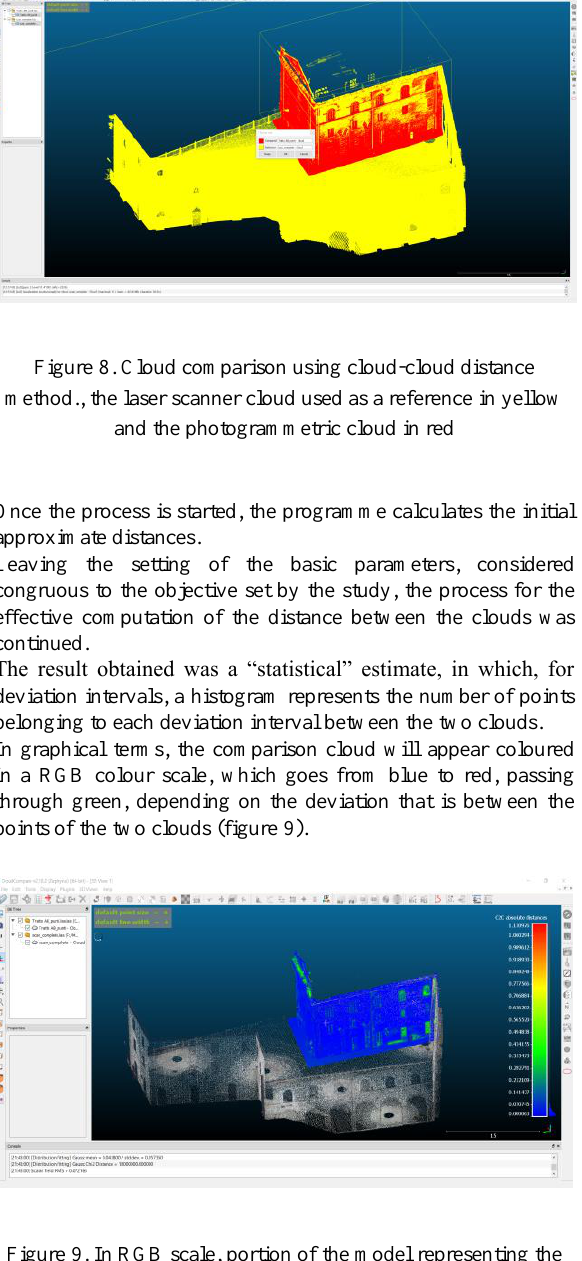
Figure 9. In RGB scale, portion of the model representing the average deviation of each